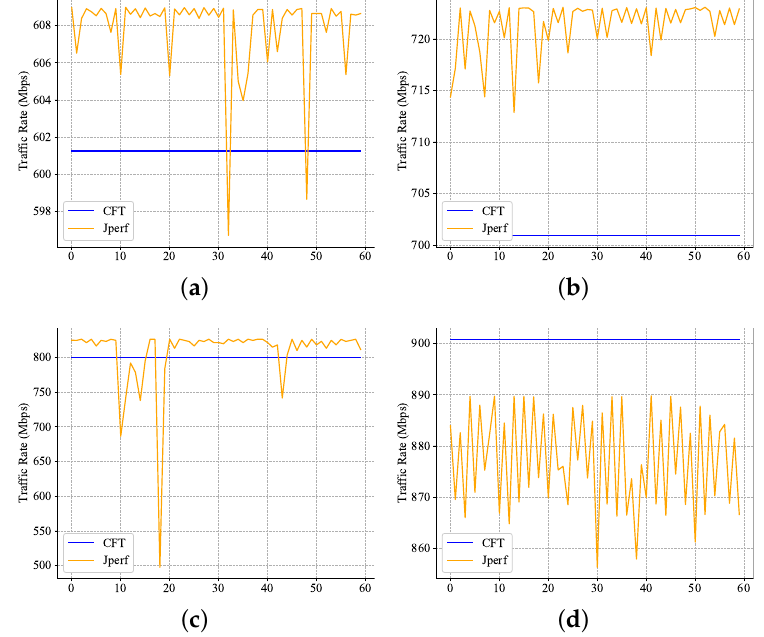
Figure 10. The comparison of the performance between the CFT and the Iperf software network tester at different rates; ( a ) traffic rate—600 Mbps, ( b ) traffic rate—700 Mbps, ( c ) traffic rate—800 Mbps, ( d ) traffic rate—900